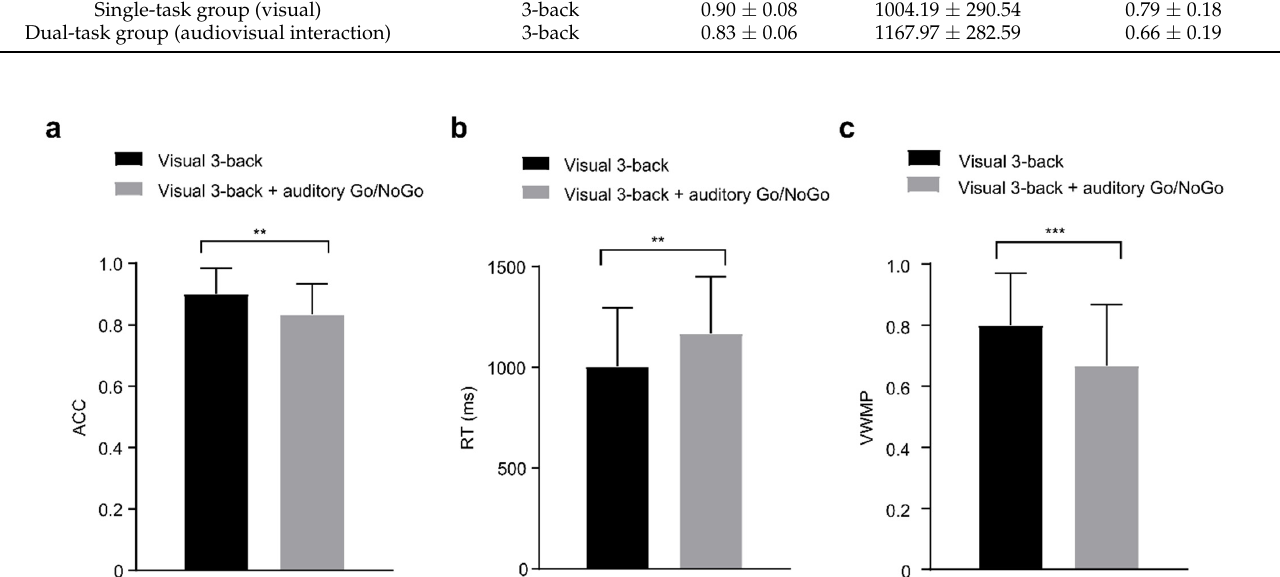
Figure 3. In the 2-back conditions, ( a ) single-task (visual) and dual-task (audiovisual interaction) groups for accuracy (ACC); ( b ) single-task (visual) and dual-task (audiovisual interaction) groups for reaction time (RT); ( c ) as well as single-task (visual) and dual-task (audiovisual interaction) groups for performance data (visual working memory performance, VWMP). Between the single-task (visual) and dual-task (audiovisual interaction) groups revealed that the RT in the dual visual 2-back + auditory Go/NoGo task was significantly longer than that in the single visual 2-back task. All the data are presented as the mean ± S.D ( n = 44); *** p < 0.001. In the 3-back conditions, accuracy, reaction times, and performance data of the sin- gle-task group (visual) and dual-task group (audiovisual interaction) were statistically an- alyzed and are shown in Table 3. Table 3. Behavioral performance parameters in the single-task group (visual) and dual-task group (audiovisual interaction) were statistically analyzed (mean ± standard deviation).